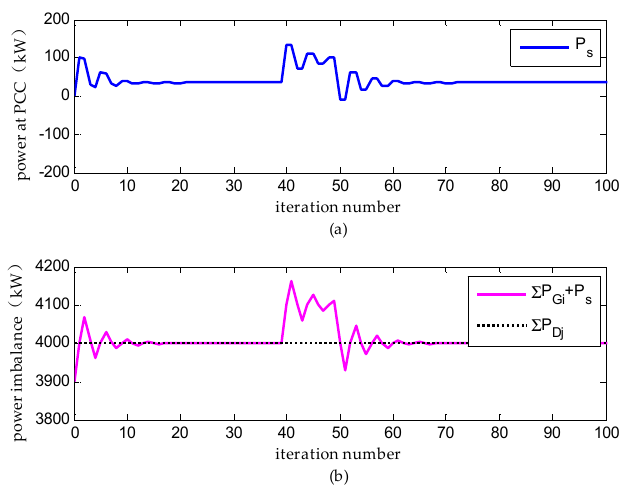
Figure 13. The simulation of power balance in Scenario E . ( a ) Power at PCC; and ( b ) The variation of power imbalance.